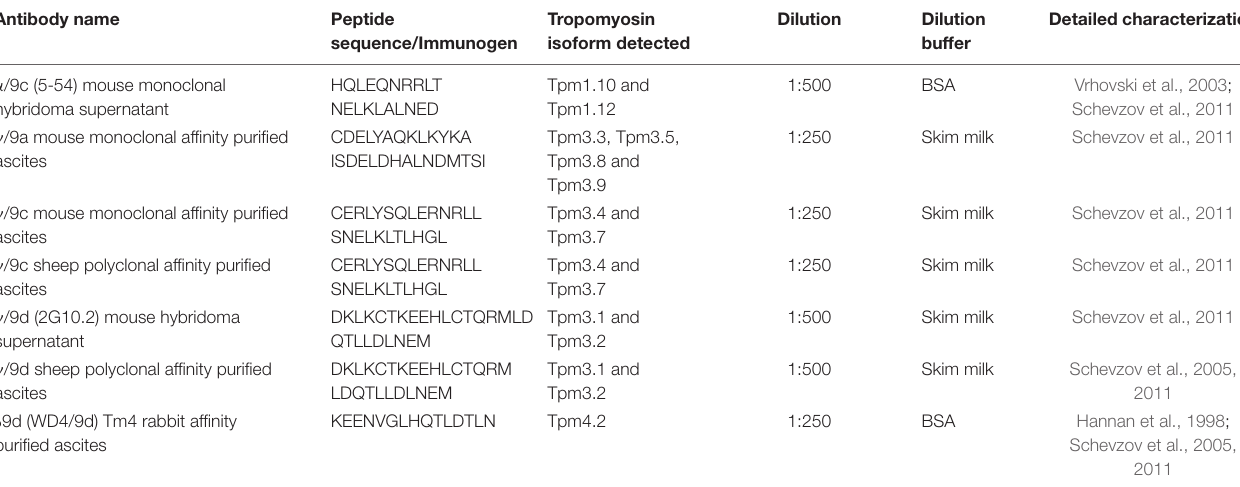
TABLE 1 | Antibodies used for the detection of different tropomyosin antibodies via Western